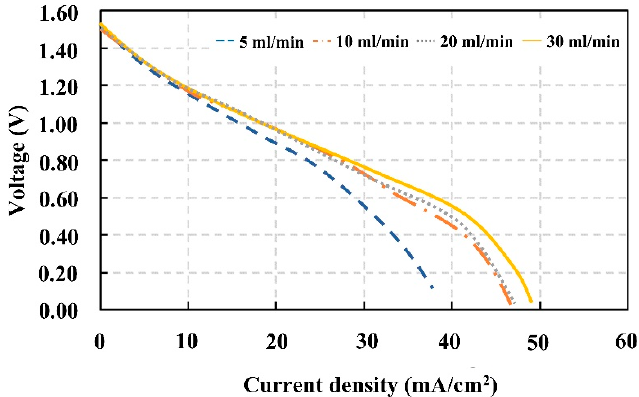
Figure 8. Polarization curves obtained from the discharging process after electrolyte preparation with different electrolyte flow rates.